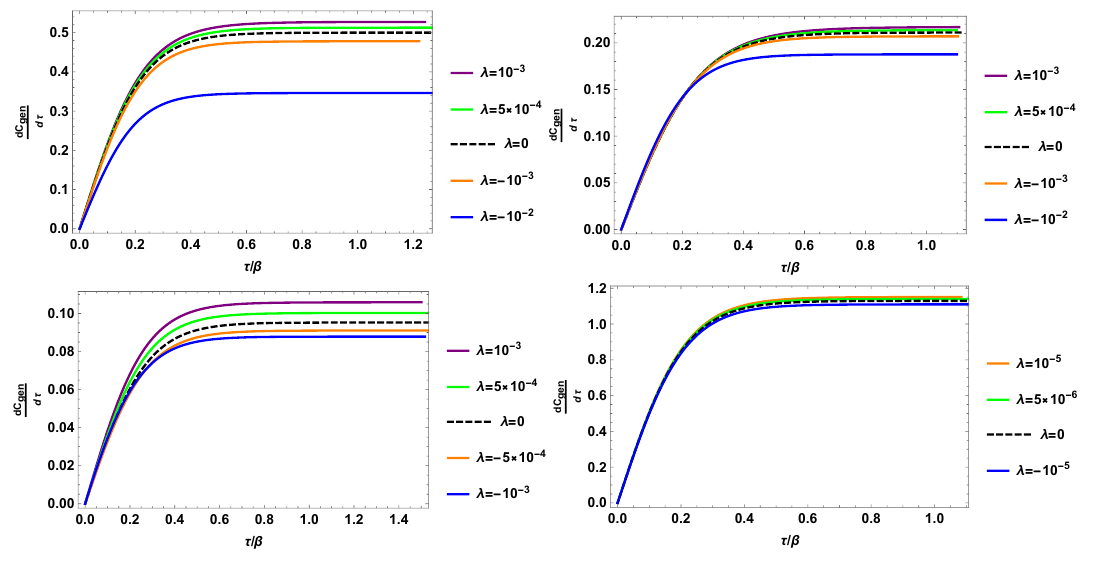
as a function of τ/β for different values of λ 6 = 0 : Top Left ) dτ = G = V = 1 and r = 0 . 5 h N d F